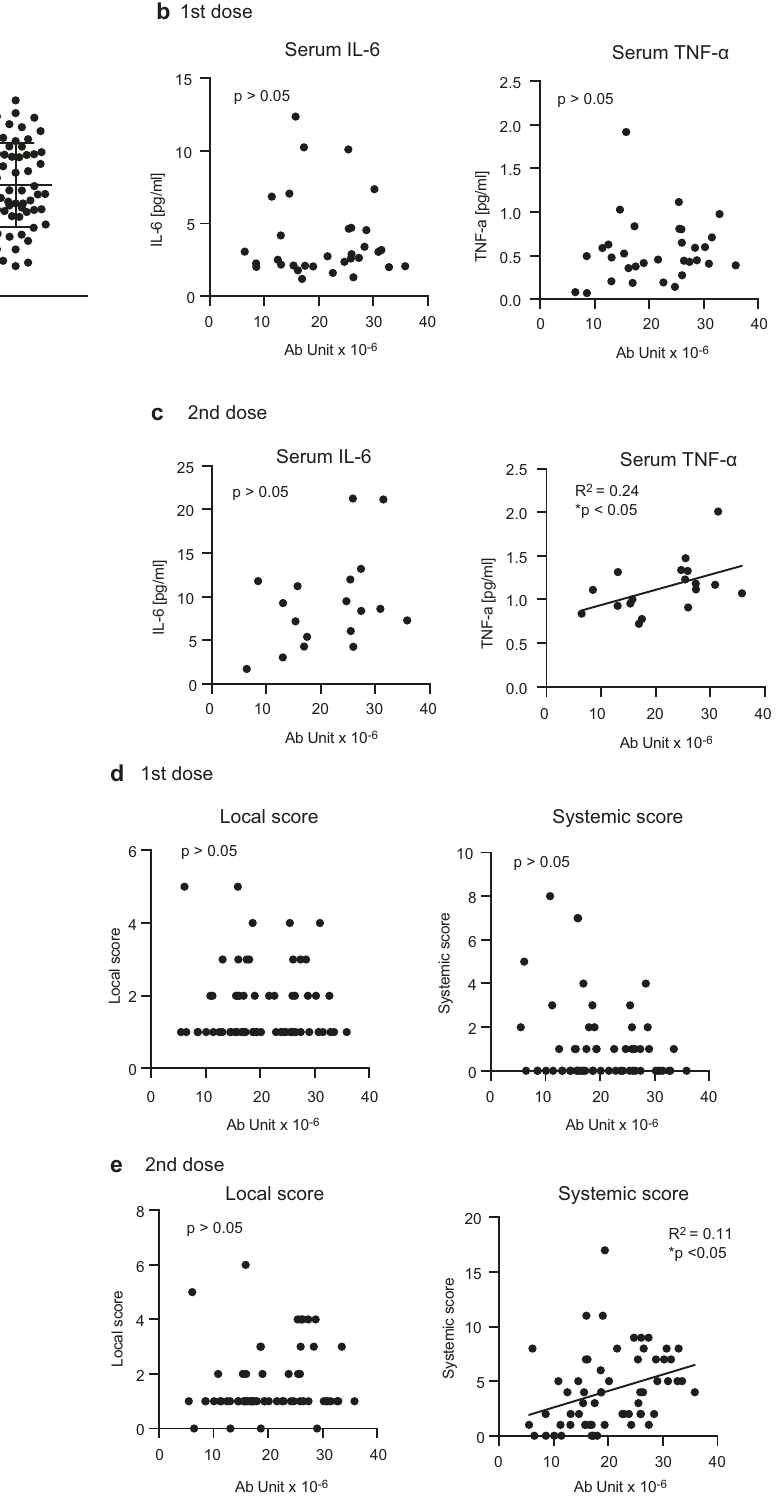
Fig. 5 Anti-spike-protein antibody titers. a Anti-spike-protein antibody titers in sera at 35 days after the fi rst dose were determined via ELISA. b , c Speci fi c antibody titers were compared with serum IL-6 and TNF- α levels 1 day after the fi rst ( b ) and second ( c ) doses. d , e Speci fi c antibody titers were compared with local and systemic scores after the fi rst ( d ) or second ( e ) doses. The coef fi cient of determination and p -values of correlation were calculated (Pearson correlation test, * p < 0.05). Each dot represents a